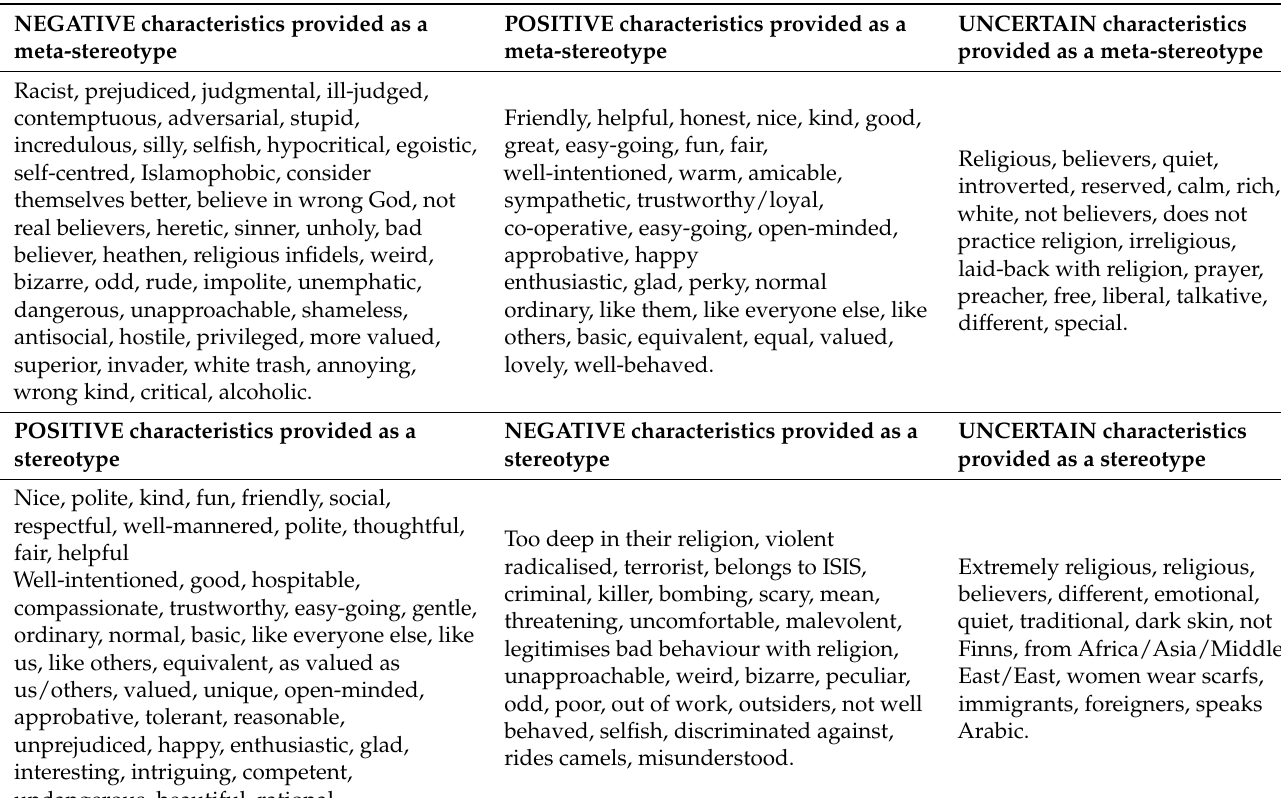
Table 1. Negative, positive, and uncertain meta-stereotype and Muslim stereotype characteristics provided by Christian background youth categorised according to their evaluative